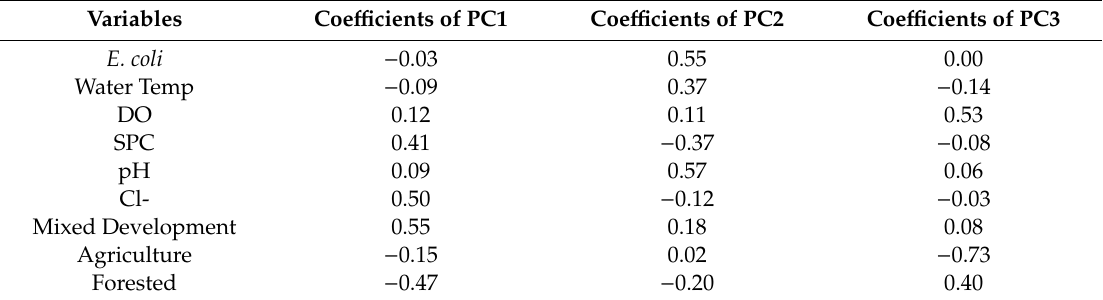
Table A8. Coe ffi cients of annual principal components comprising 9 variables ( E. coli concentration, water temperature, DO, SPC, pH, chloride, percentage of mixed developed land use, percentage of agricultural land use and percentage of forested land use) used to define 9 principal components,